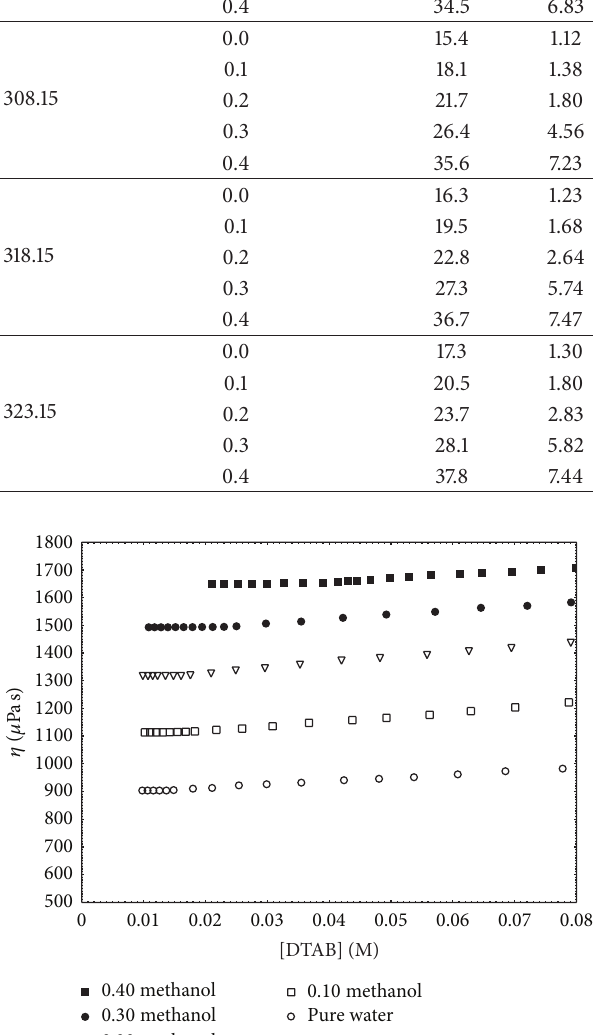
Figure 3: Viscosity versus concentration of DTAB solution at 298.15 K.